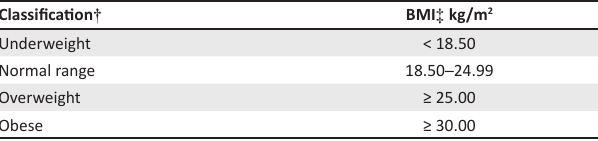
TABLE 3: Classification of body mass index.